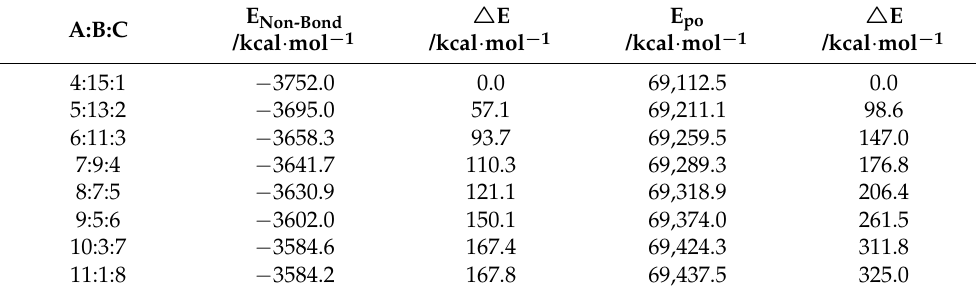
Figure 2. Molecular structure of three tetramers in aluminum sol. Table 1. The non-bond energy and the potential energy of aluminum sol models varied with component proportion.